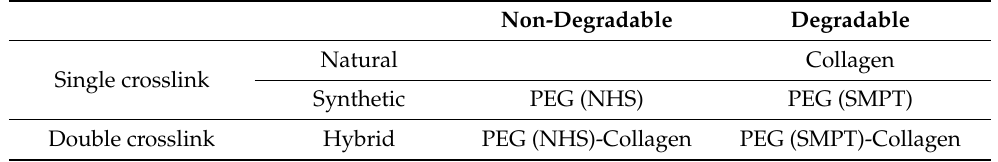
Table 2. Different hydrogel samples used in this